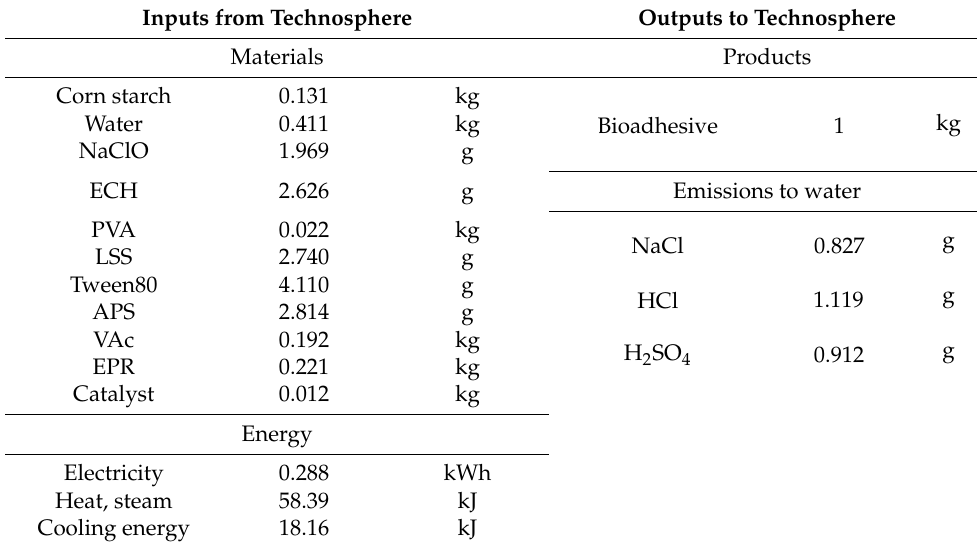
Table 4. Inventory data for the production of starch bioadhesive oxidized with NaClO and ECH (Alternative 4). Detailed data per functional unit (1 kg of bioadhesive). Acronyms: epichlorohydrin (ECH), polyvinyl alcohol (PVA), lauryl sodium sulfate (LSS), ammonium persulfate (APS), vinyl